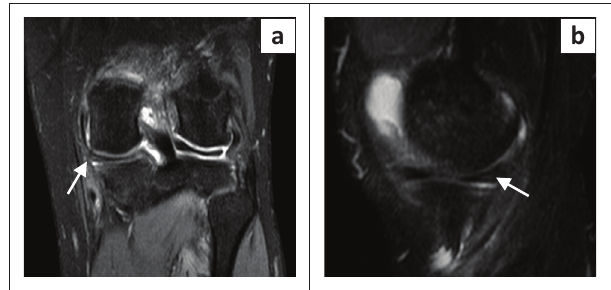
FIGURE 6: True positive medial meniscus tear: (a) coronal view and (b) sagittal view.